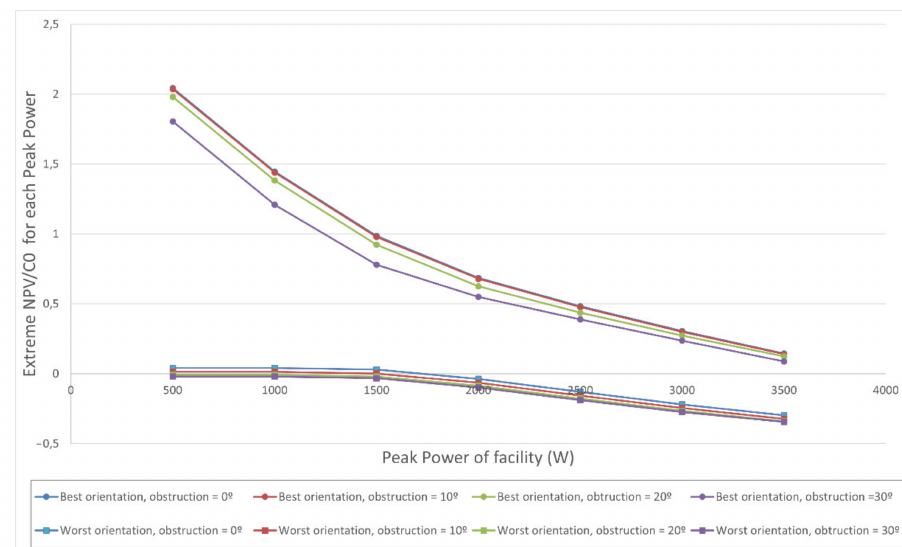
Figure 8. NPV / investment depending on peak power and degree of obstruction.